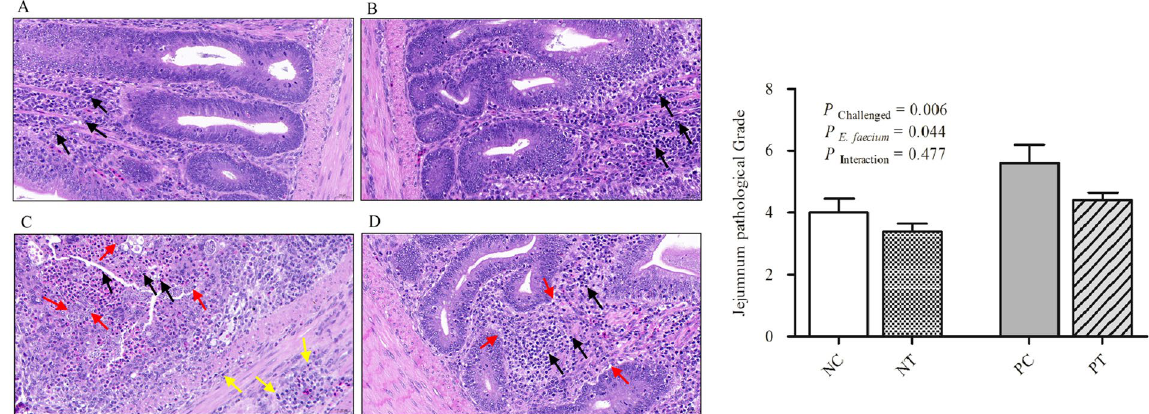
Figure 4. Effect of dietary E . faecium 11181 on histopathological changes and pathological grade of the jejunum of broiler chickens challenged with NE at d 26 (7 DPI). Histopathological changes in the ( A ) the NC group, ( B ) the NT group, ( C ) the PC group, and ( D ) the PT group. ( E ) Histopathological grade of the jejunum at d 26 (7 DPI). Values are means (n = 6) with SEM represented by vertical bars. Magni fi cation = 400 × . The black arrow shows inflammatory-cell infiltration, the red arrow shows the necrotic cell clusters with shrunken nucleoli or karyorrhexis and karyolysis, and the yellow arrow shows the connective tissue hyperplasia and inflammatory- cell infiltration in the submucosal and muscle layer.